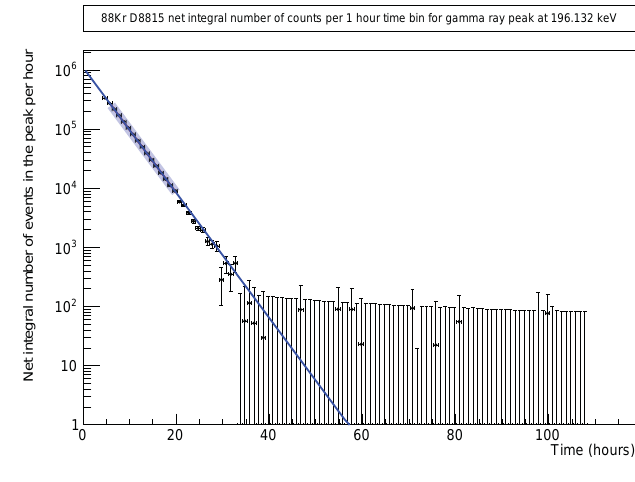
Figure 3. 88 Kr γ ray half-life plot for the 196 keV γ